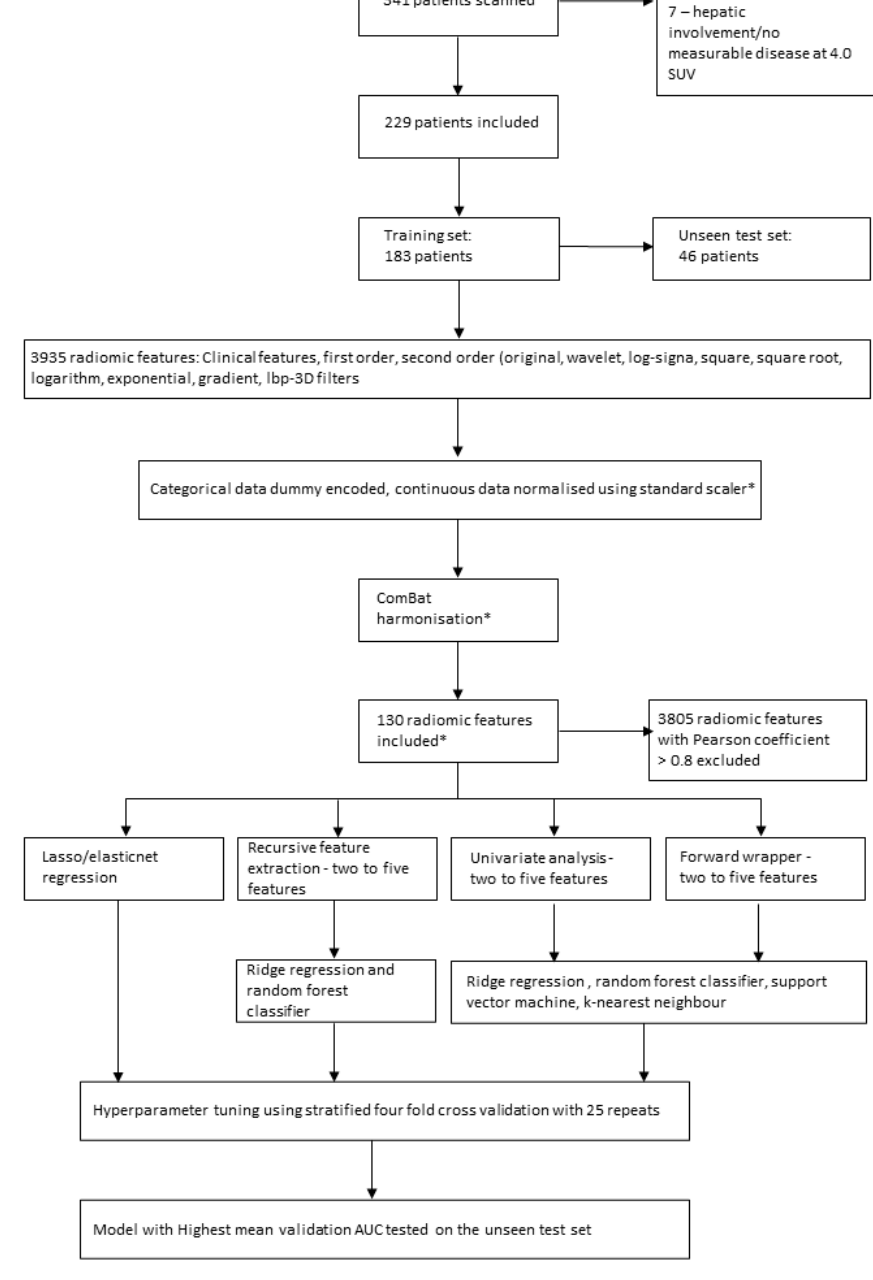
Figure 1. Pathway for patient inclusion, feature selection and model creation. * = initially applied to the training data and then to the test